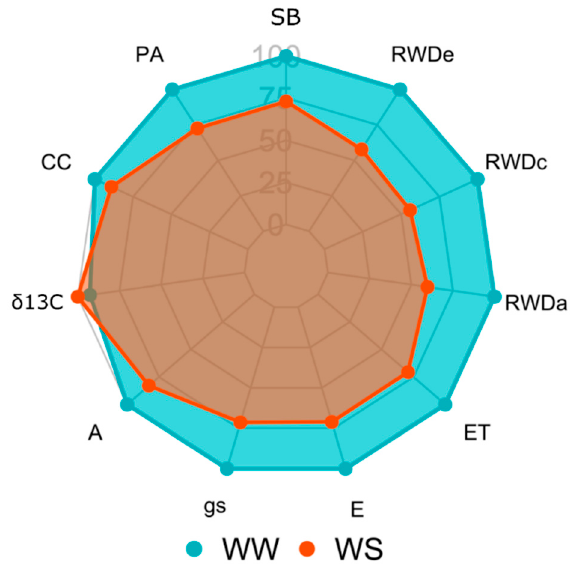
Figure 2. Comparison of average estimates obtained under water stress (WS) and well-watered (WW) conditions for morphological traits, water status, and root traits in popcorn parents and hybrids. WS: water stress; WW: well-watered; SB: shoot biomass; PA: whole plant area; CC: chlorophyll concentration (Dualex index); δ 13 C: carbon isotope discrimination; A: net CO 2 assimilation rate; gs: stomatal conductance; E: transpiration; ET: cumulative plant transpiration; RWDa: root weight density of the section a (0–30 cm); RWDc: root weight density of the section c (60–90 cm); RWDe: root weight density of the section e (120–150 cm).